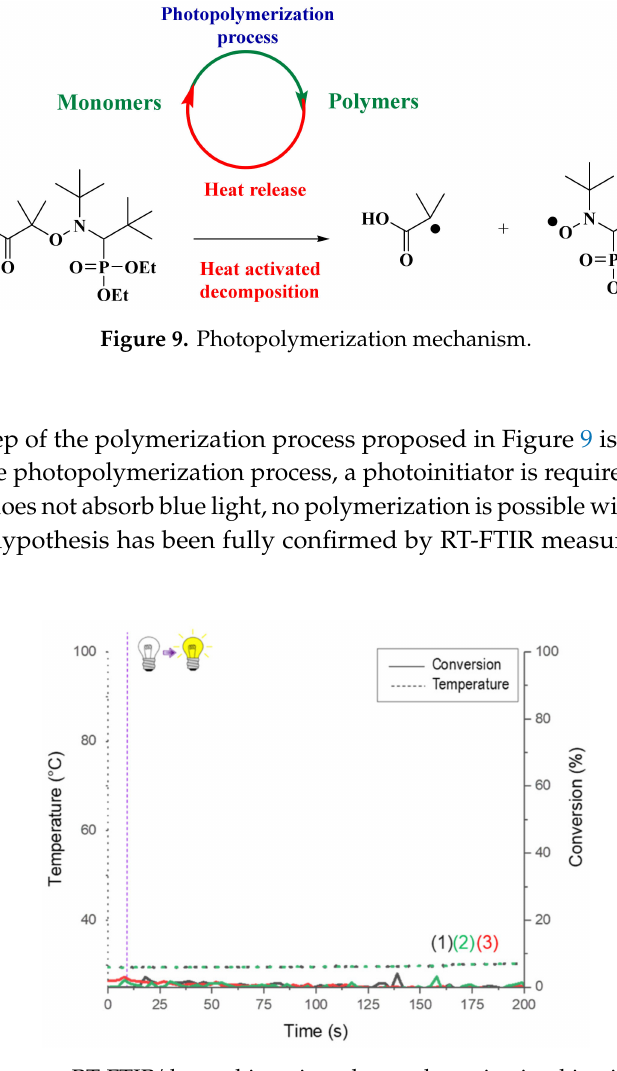
Figure 10. Simultaneous RT-FTIR / thermal imaging photopolymerization kinetics (C = C conversion vs. irradiation time and temperature vs. irradiation time; 1.4 mm sample) under air upon LED@405 nm irradiation for Mix-MA in the presence of (1) monomer alone, (2) Blocbuilder ® -MA (2 wt.%), and (3) Ar 2 I + PF 6 − (1.5 wt.%), 4-dppba (0.5 wt.%), and Blocbuilder ® -MA (2 wt.%); the irradiation starts after 10